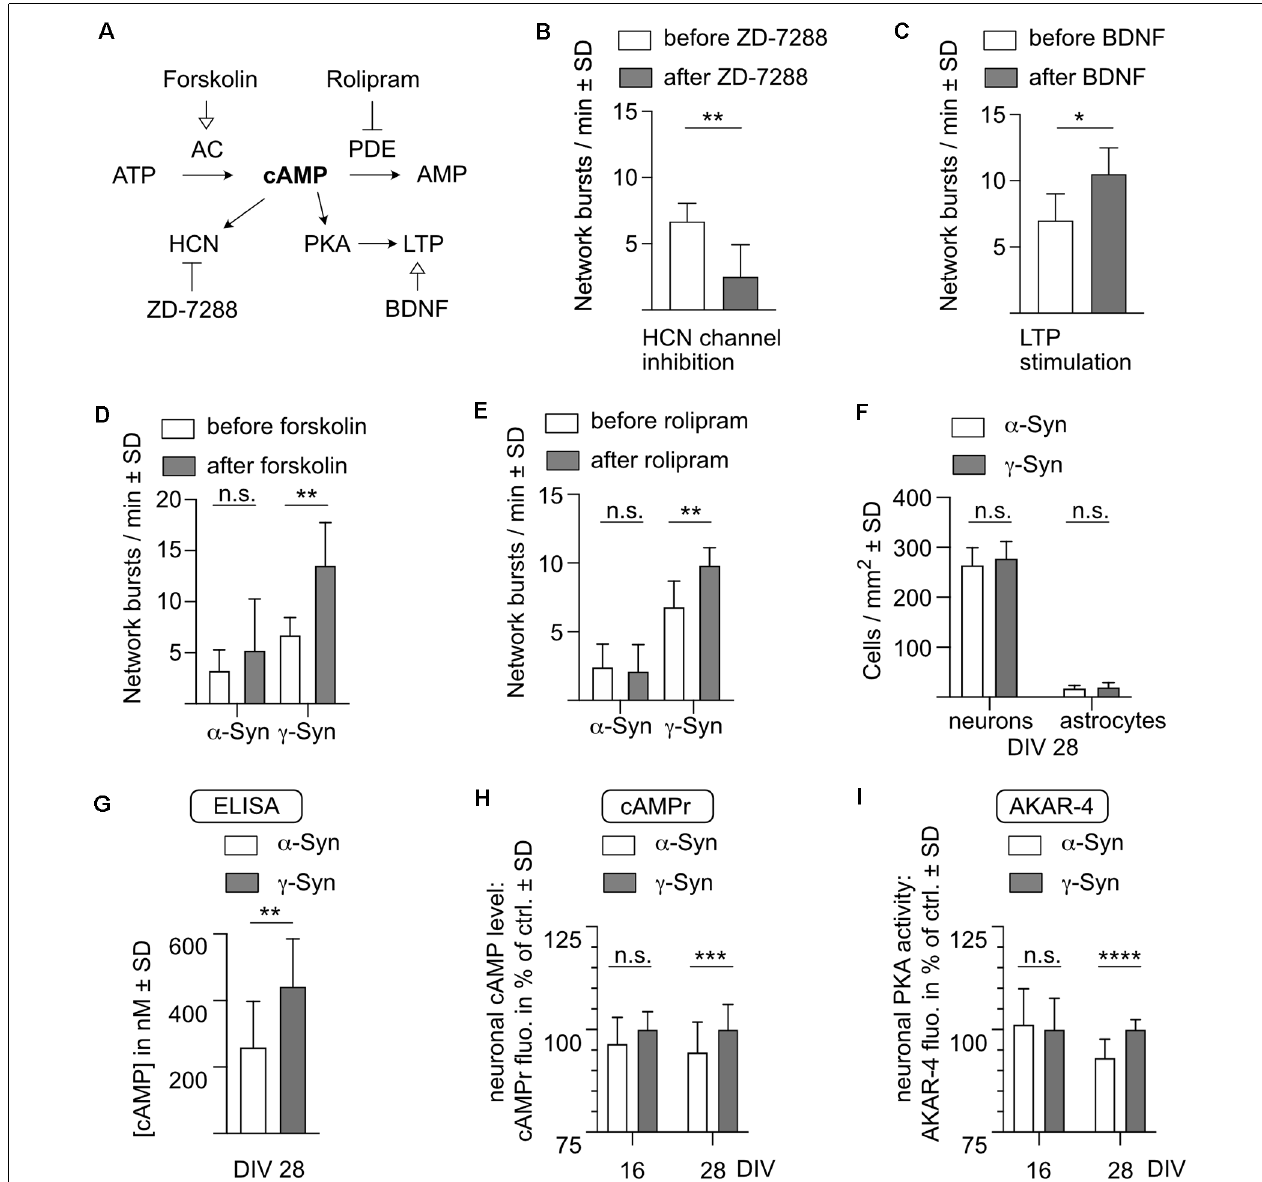
FIGURE 7 | α -Syn causes diminished levels of cAMP and PKA phosphorylation. (A) Schematic depiction of cAMP-mediated effects on network activity. AC, adenylate cyclase; AMP, adenosine monophosphate; ATP, adenosine triphosphate; BDNF, brain-derived neurotrophic factor; cAMP, cyclic adenosine monophosphate; HCN, hyperpolarization-activated cyclic nucleotide-gated channel; LTP, long-term potentiation; PDE, phosphodiesterase; PKA, protein kinase A. (B) HCN channel inhibitor ZD-7288 reduces the frequency of network bursts. At DIV 28, network activity was determined before (white bars) and 30 min after (dark bars) addition of 10 µ M ZD-7288 to neurons which do not express human synuclein. (C) BDNF stimulates network activity. At DIV 28, network activity was determined before (white bars) and 30 min after (dark bars) addition of 2 nM BDNF to neurons which do not express human synuclein. (D) Forskolin stimulates network activity only in γ -Syn expressing neurons. At DIV 28, network activity was determined before (white bars) and 30 min after (dark bars) addition of 1 µ M forskolin in either α -Syn (left) or γ -Syn (right) expressing neurons. (E) Rolipram stimulates network activity only in γ -Syn expressing neurons. At DIV 28, network activity was determined before (white bars) and 30 mi after (dark bars) addition of 1 µ M rolipram in either α -Syn (left) or γ -Syn (right) expressing neurons. (F) As a prerequisite for the determination of cAMP levels by ELISA, numbers of neurons and astrocytes were quantified at DIV 28. (G) Quantification of cAMP levels by ELISA at DIV 28 in cultures expressing α -Syn (white bar) or γ -Syn (gray bar). (H) Quantification of neuronal cAMP levels at DIV 16 and DIV 28, as determined by the fluorescent signals of the cAMPr sensor α -Syn expressing neurons (white bars) and in γ -Syn expressing neurons (dark bars). Quantification normalized to γ -Syn expressing neurons at DIV 16 = 100%. (I) Quantification of neuronal PKA phosphorylation at DIV 16 and DIV 28, as determined by the fluorescent signals of the AKAR4-cAMPs sensor in α -Syn expressing neurons (white bars) and in γ -Syn expressing neurons (dark bars). Quantification normalized to γ -Syn expressing neurons at DIV 16 = 100%. N (as independently recorded neuron cultures) = 6–8 in (B,C) ; 10 in (D,E) ; 12 in (F,G) ; 6 in (H) , DIV 16; 36 in (H) , DIV 28; 12 in (I) , DIV 16; and 18 in (I) , DIV 28. Statistics by two-tailed paired or unpaired T-test as appropriate. n.s. = not significant; * p < 0.05; ** p < 0.01; *** p < 0.001; **** p < 0.00001. Statistical power (1 – ß error probability) = 91% in (B) ; 78% in (C) ; 99% in (D) ; 96% in (E) ; 92% in (G) ; 93% in (H) ; 100% in (I) .